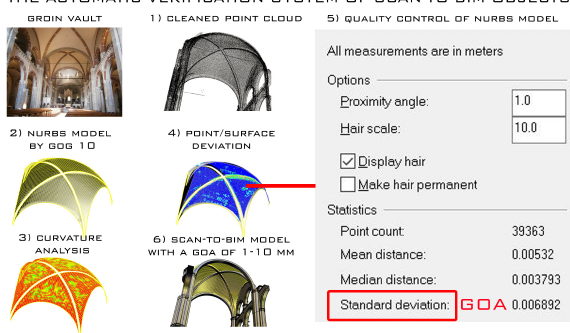
Figure 5. The AVS allowed the quality control of the